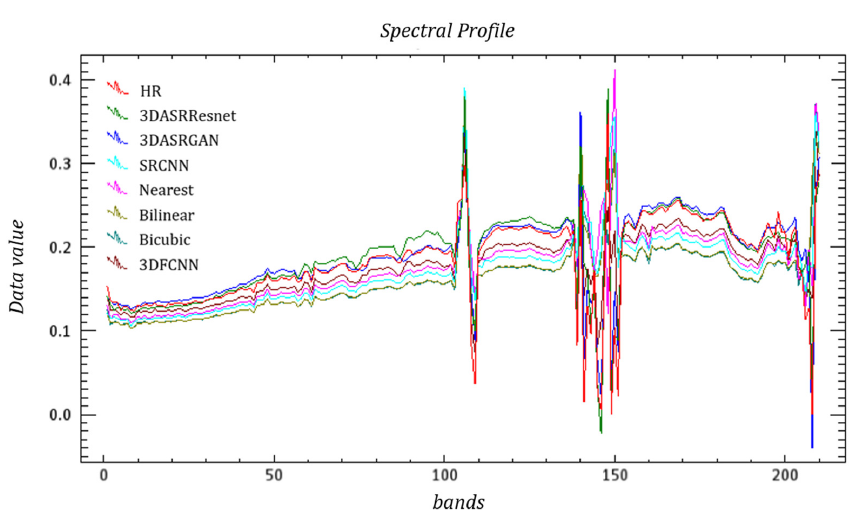
Figure 14. Example Spectral Curves of Road based on the Urban dataset.